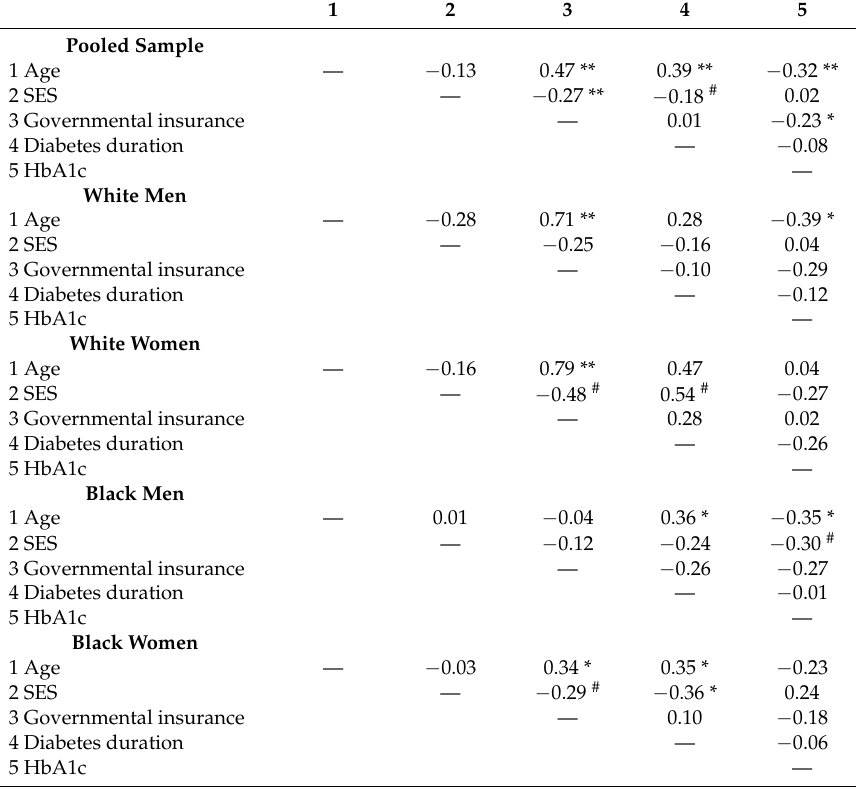
Table 2. Pearson correlations for the pooled sample and race by gender subgroups.